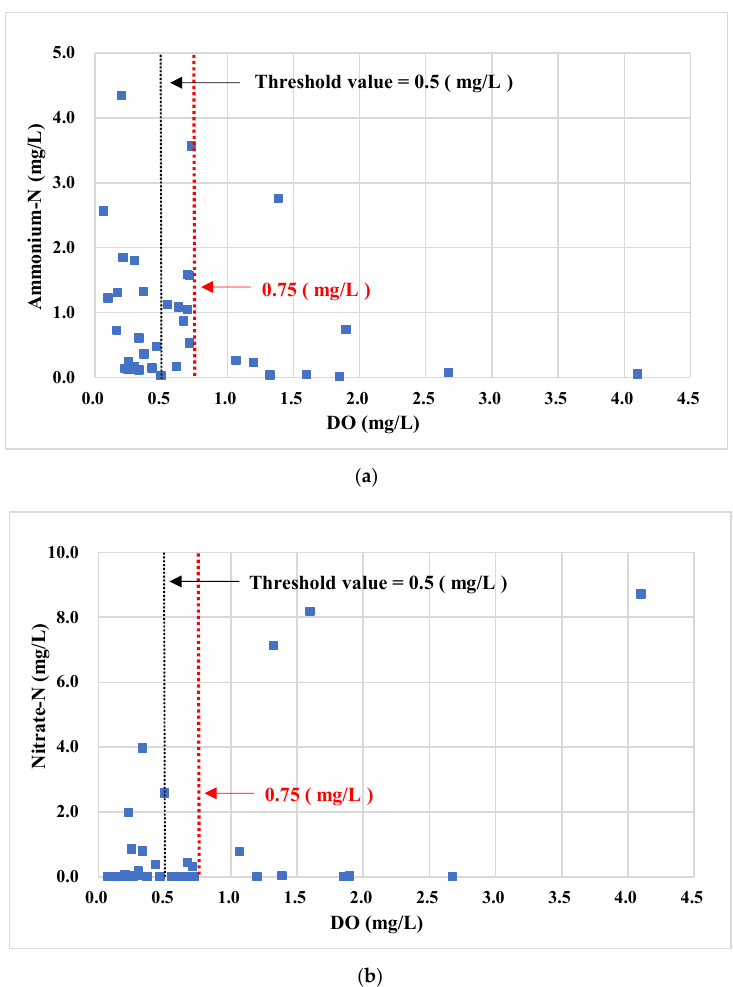
Figure 10. Scatter plots of ( a ) ammonium–N vs. dissolved oxygen (DO) and ( b ) nitrate–N vs. DO.